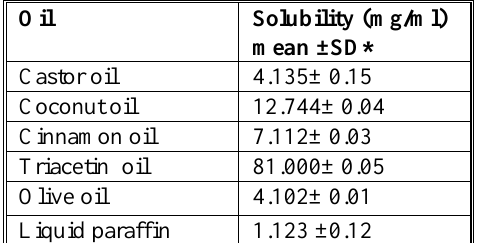
Table1 . Saturation solubility of isradipine